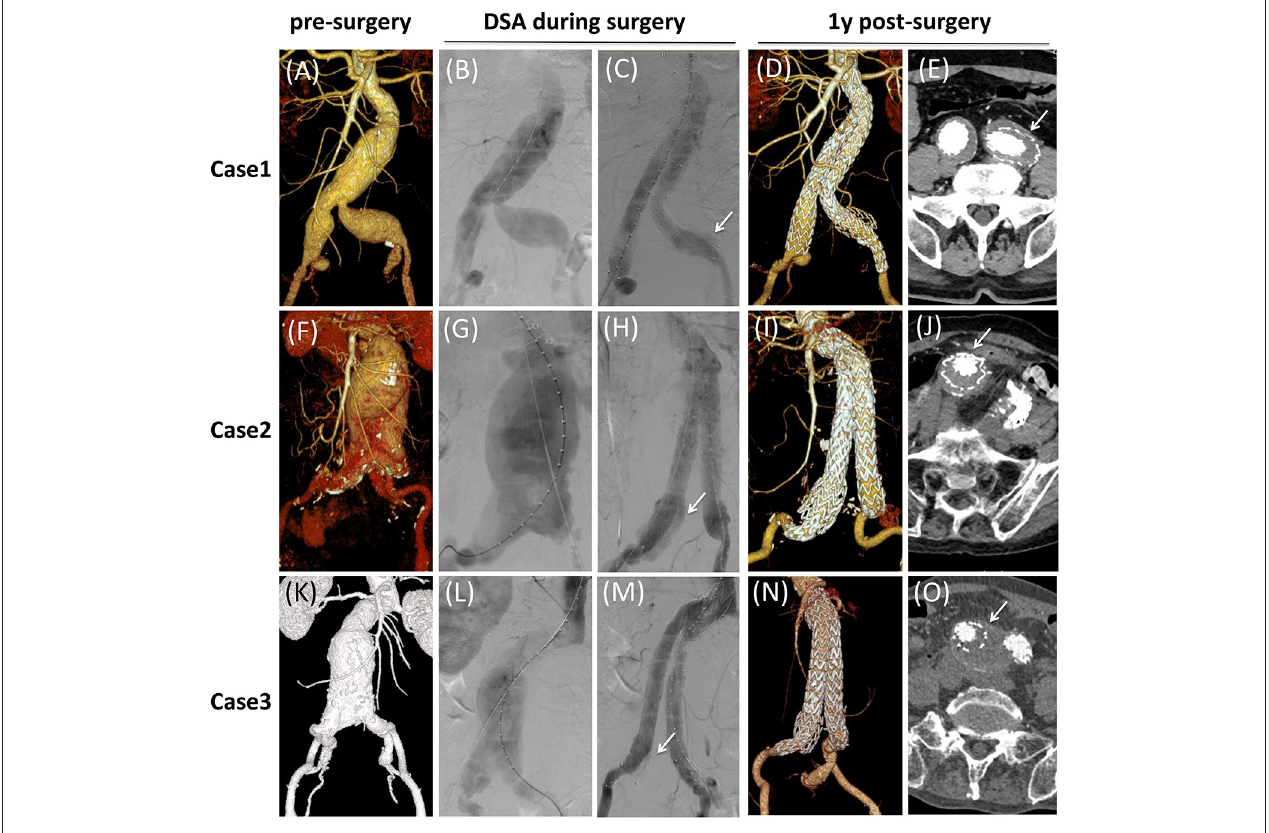
FIGURE 2 | Typical cases of CST for aorto-iliac aneurysms. (A,F,K) Pre-surgical CTA 3D reconstruction. (B,G,L) DSA of aneurysms. (C,H,M) DSA after CST procedure. The white arrow indicates reflux of IIA was contained between the skirt graft and the extended iliac limb. (D,I,N) One-year follow-up CTA 3D reconstruction. (E,J,O) Transverse section of 1-year follow-up CTA. The white arrow indicates thrombosis formed in space between skirt graft and extended iliac